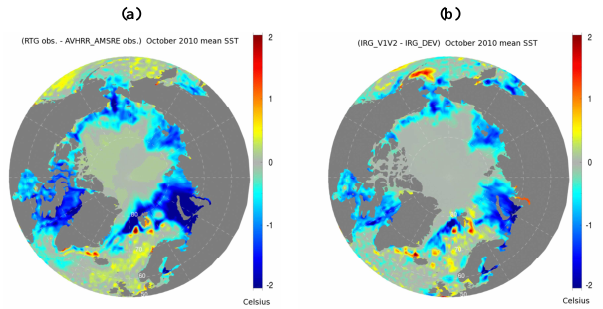
Fig. 12. October 2010 mean difference (°C) between (a) assimilated SST products in IRG_V1V2 and IRG_DEV and (b) IRG_V1V2 and IRG_DEV SST analyses.